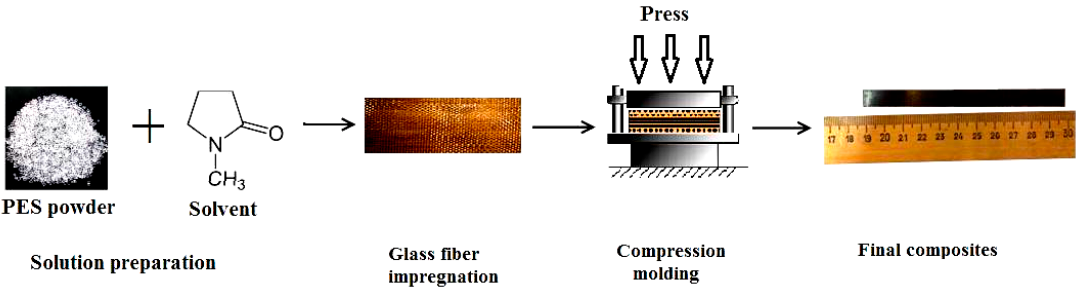
Figure 1. Preparation steps of polyethersulfone (PES) composites with compression molding.